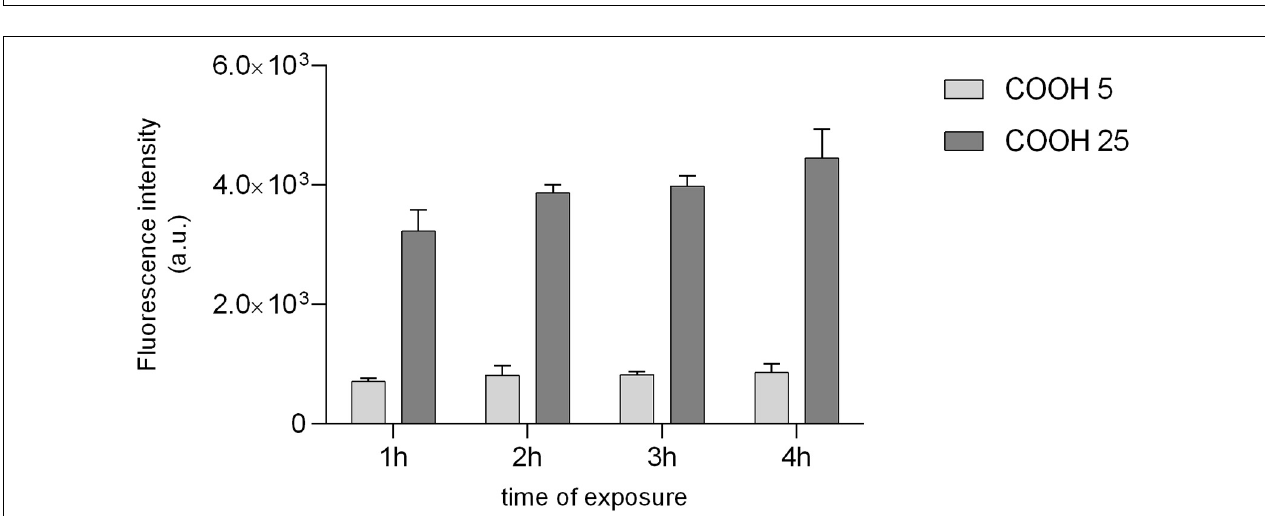
FIGURE 4 | Phagocytosis activity assay in sea urchin phagocytes. Phagocytic capacity (PC, %) (A) and phagocytic index (PI, %) (B) calculated on P. lividus phagocytes after 4 h of exposure to PS-COOH (5 and 25 µ g mL − 1 ) and PS-NH 2 (25 µ g mL − 1 ). Data are reported as mean ± SD ( n = 9, Kruskal–Wallis test, Dunn’s post-test, * p < 0.05, ** p < 0.01). Asterisks indicate significant differences with respect to the control group.